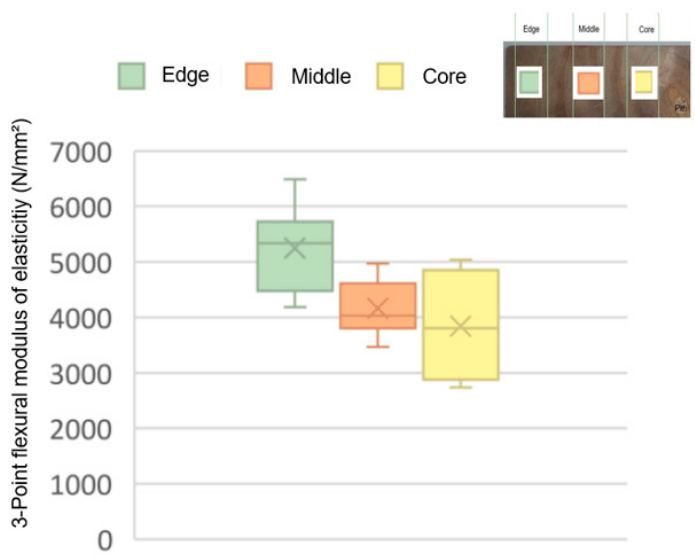
Figure 15. Modulus of elasticity in the cross-section of the Paulownia’s tree stem. Relatively similar values were reported by [5], from 4500 to 4900 N/m 2 . Almost half of these values, namely 1900 N/mm 2 , was MOE analyzed by [19]. The bending properties of Paulownia were significantly influenced by the density and porosity of the wood. Kiaei [17] measured a high porosity rate of 83% for Paulownia species sourced from Iran. In this study, MOR was, on average, 41 N/mm 2 and MOE was 3740 N/mm 2 , which are consistent with the finding of this study considering a trunk height of 0–1 m and the area positioned between the pith and near the bark of the samples of Paulownia sourced from Serbia. The high microfibril angle (mostly of juvenile wood) significantly influenced the elastic behavior of Paulownia plantation wood. A comparison with other studies regarding